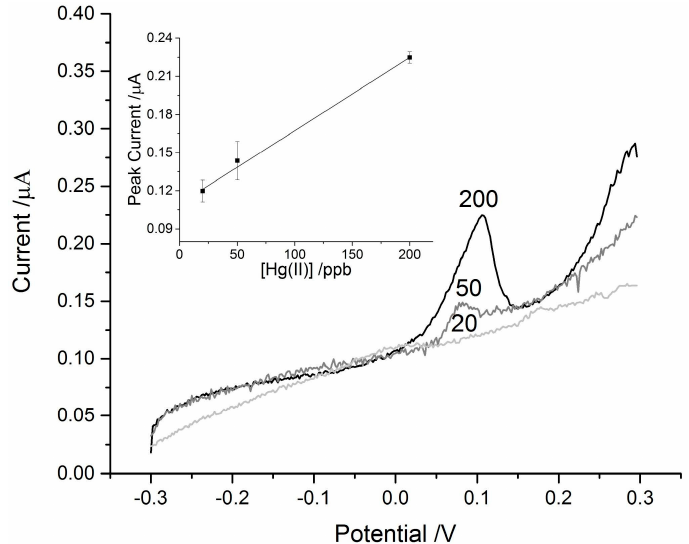
Figure 6. Representative ASV scans of blank paper discs on SPCEs with 25 μ L aliquots of Hg 2+ solutions of concentrations 20, 50 and 200 ppb. The concentration corresponding to each trace is labeled near the peaks at +0.1 V. Inset in the top left corner is the linear fit of the control data (n = 3).